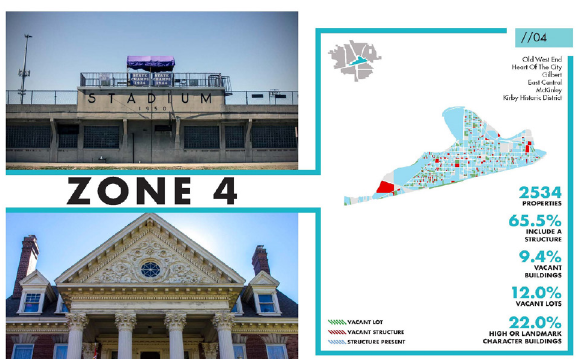
Figure 3. Results of ScoutMuncie for the downtown area of Muncie illustrating the percentage of unproductive properties (vacant buildings and vacant lots) and wealth of